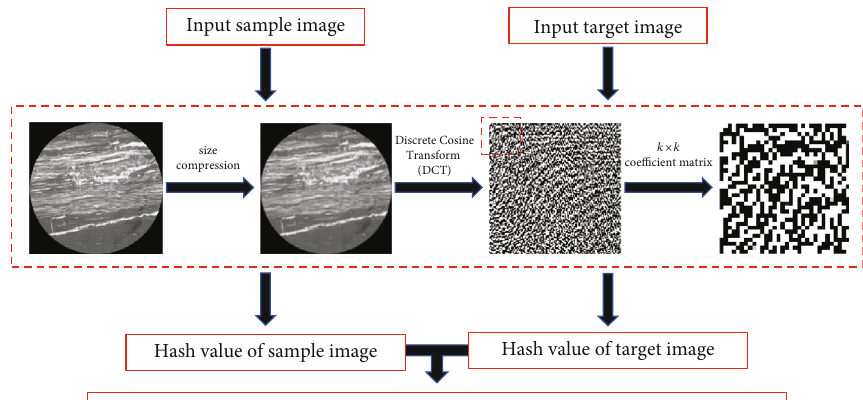
Figure 1: Similarity detection process of CT